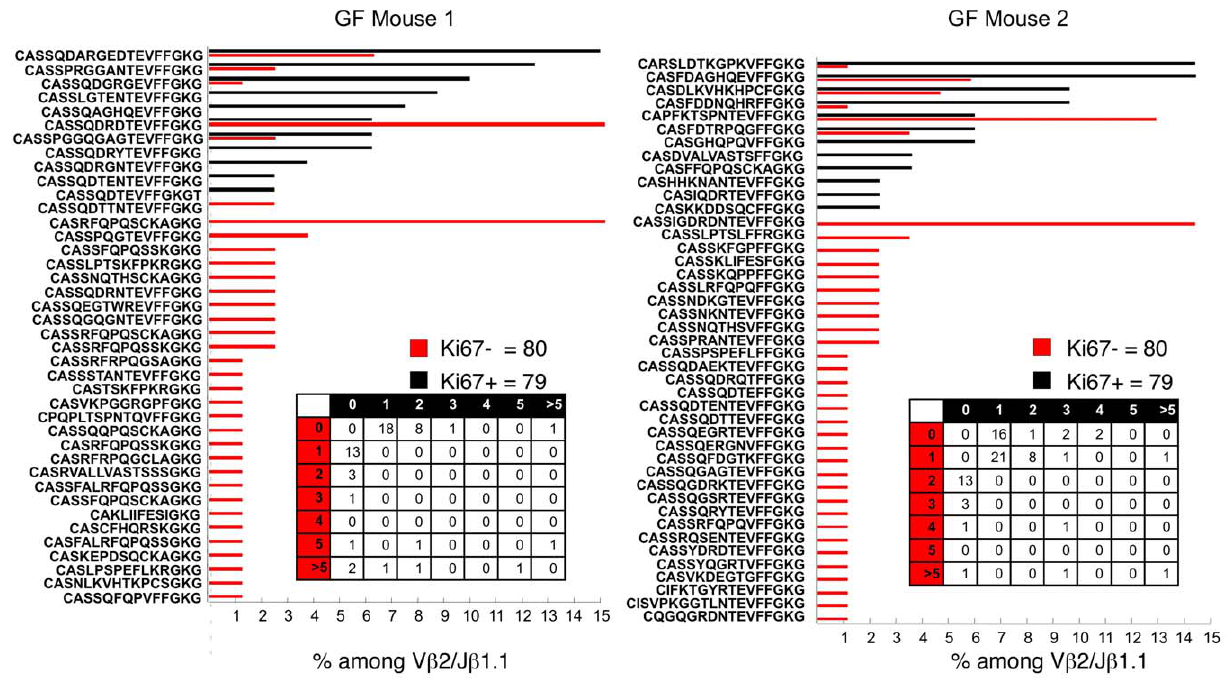
Figure 8. Sequence diversity among proliferating and nonproliferating V b 2-J b 1.1 cells in B6 GF mice. Sequence diversity among Ki- 67 bright and Ki-67 negative V b 2-J b 1 CD44 + CD4 T-cell populations. Shown is the percentage of times an individual sequence occurred in two GF mice.